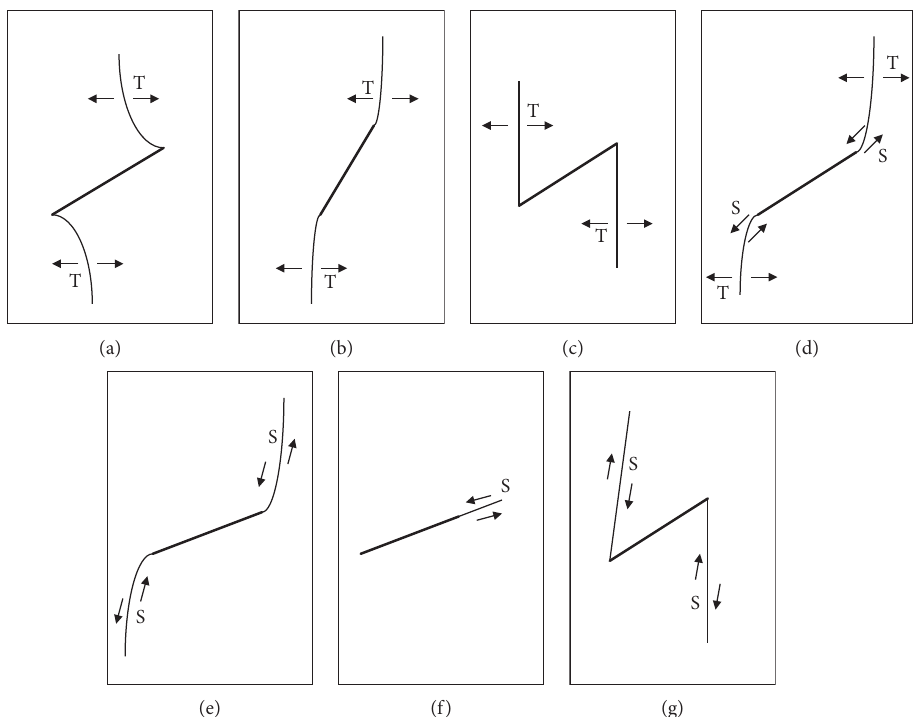
Figure 1: Various types of cracks induced by prefabricated flaws (Wong and Einstein [4]). Tand S represent tensile crack opening and shear sliding, respectively. (a) Type 1 tensile crack (tensile wing crack). (b) Type 2 tensile crack. (c) Type 3 tensile crack. (d) Mixed tensile-shear crack. (e) Type 1 shear crack. (f) Type 2 shear crack. (g) Type 3 shear